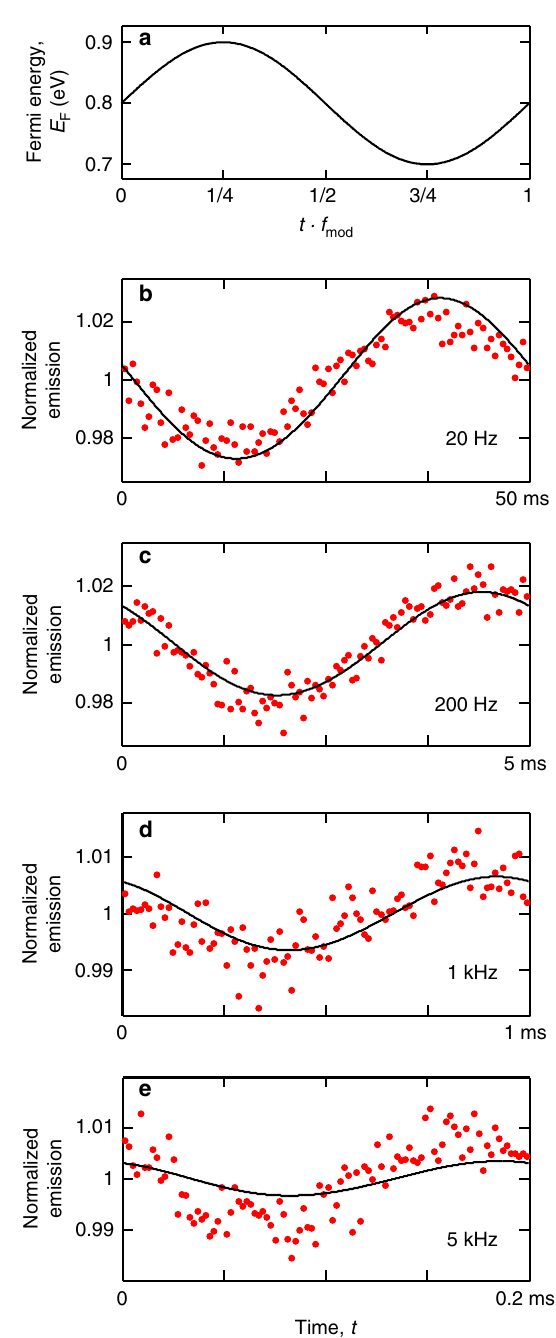
Fig. 4 Dynamic modulation within the intraband regime. a Fermi energy as a function of time t using a sinusoidal function of frequency f mod (schematic). The slow topgate is used to tune to E F ~ 0.8 eV, whereas the fast backgate provides the modulation between 0.7 and 0.9 eV, thus modulating the interaction strength within the intraband regime. b – e Time- resolved photon emission while the Fermi energy is modulated at different frequencies between 20 Hz and 5 kHz (red dots). Every time-modulated emission measurement is normalized to its mean value, so that the modulation does not depend on the excitation laser power or the photon collection ef fi ciency. The black solid curves show the dynamic simulations of N ions located at the distribution of distances from graphene P ( z ) obtained from the emission contrast measurements and decay curves (see “ Methods ” ). Note that the modulated emission is out of phase with the modulating Fermi energy, because a higher Fermi energy gives lower emission in the intraband